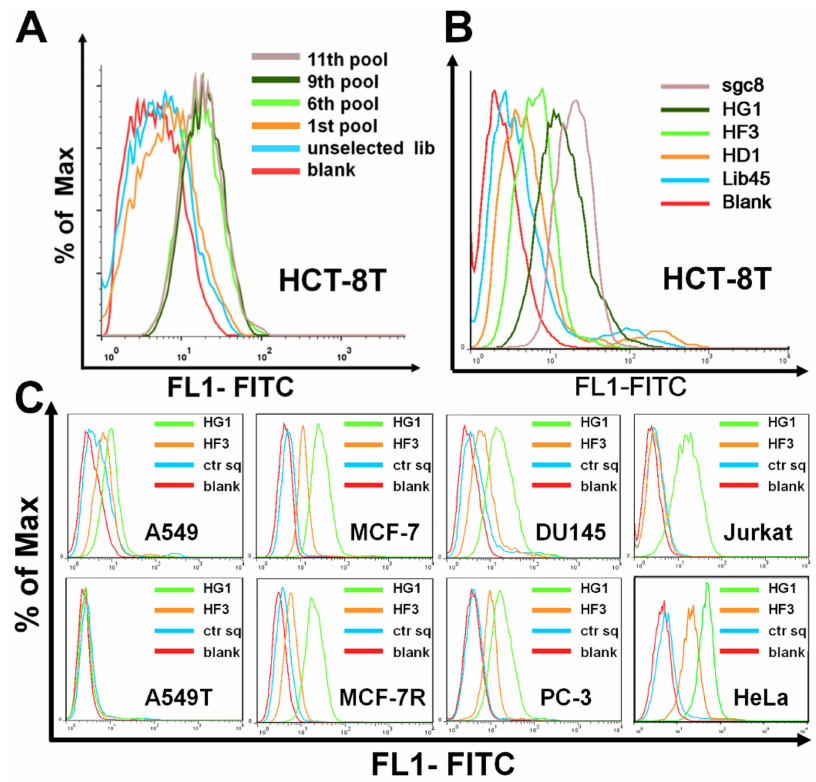
Figure 1. Monitoring the enrichment of cell-SELEX process. ( A ) Histogram of fluorescence intensity of enriched ssDNA pool on HCT-8T cells by flow cytometry, unselected DNA library was used as the negative control. ( B ) Histogram of fluorescence intensity of DNA sequences HG1, HD1, and HF3 on HCT-8T cells by flow cytometry, Lib45 was used as the negative control and PTK7-targeted aptamer sgc8 was the positive control. ( C ) Flow cytometry analysis of HG1 and HF3 binding to 8 different cell lines (A549, A549T, MCF-7, MCF-7R, DU145, PC-3, Jurkat, and HeLa cells). The ctr sq was as negative